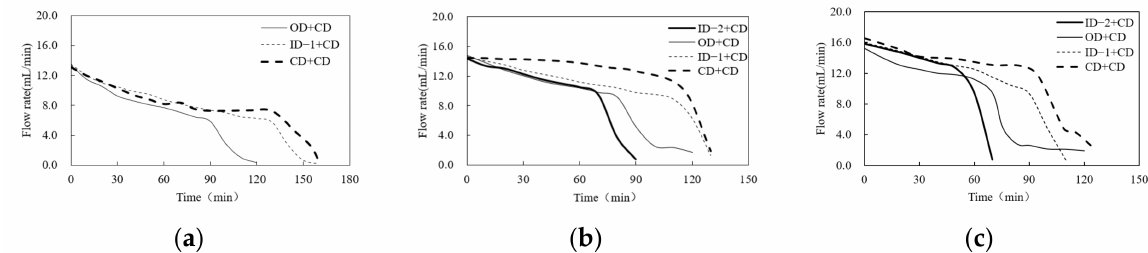
Figure 5. Flow-rate variation process over time; ( a ) Deep–deep combination; ( b ) Medium–deep combination; ( c ) Medium– medium combination; ( d ) Shallow–deep combination; ( e ) Shallow–medium combination; ( f ) Shallow–shallow combination.